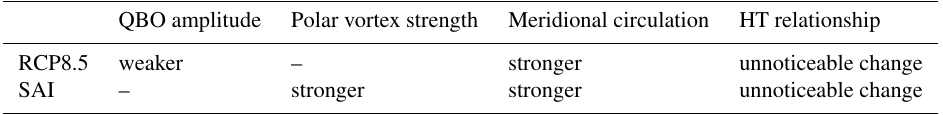
Table 2. The same as Table 1 but for the January–February